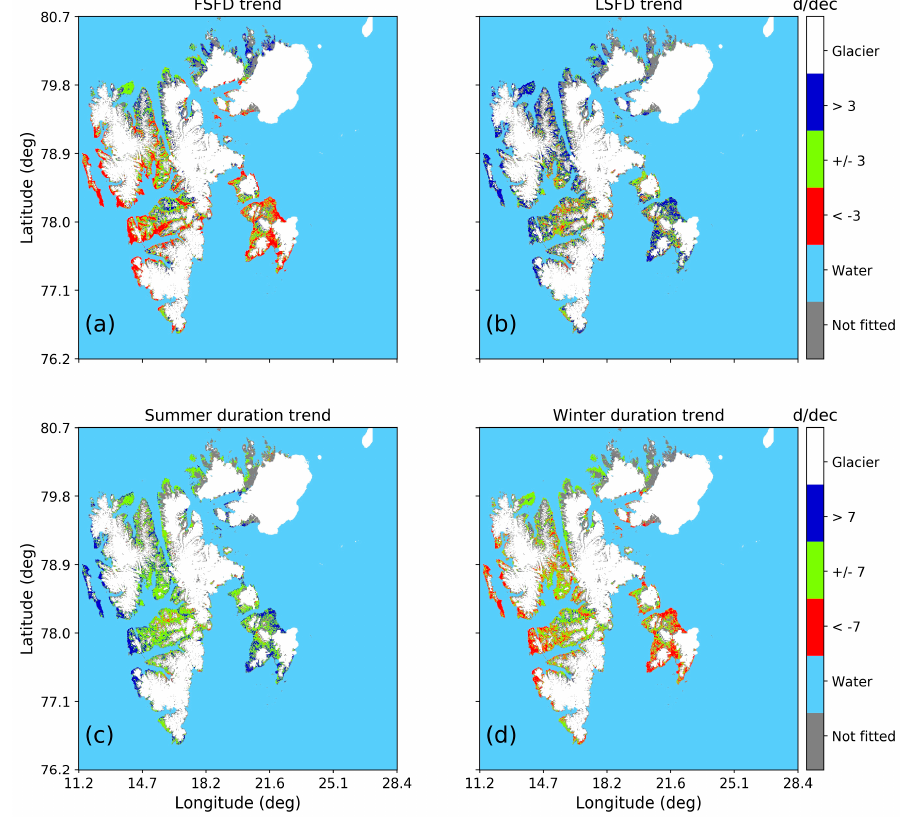
Figure 8. Trends in ( a ) first snow-free day ( b ) last snow-free day ( c ) length of summer and ( d ) length of winter between 2000 and 2019. Trends are given in days decade − 1